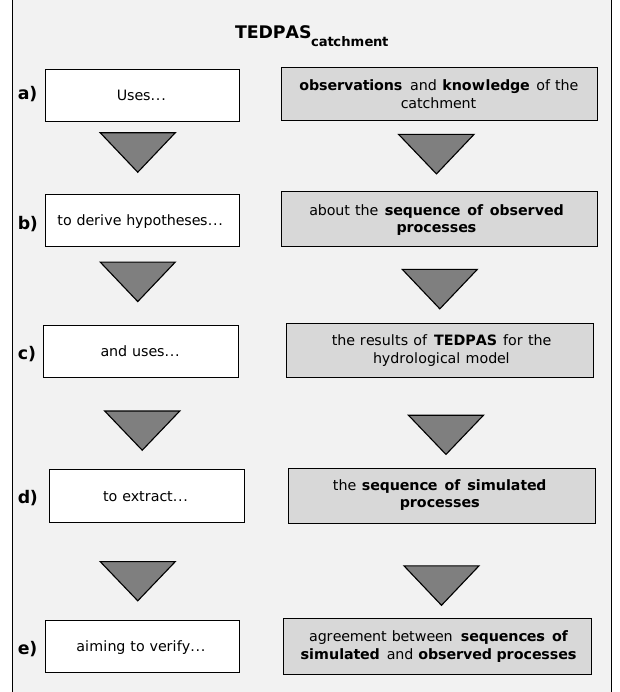
Figure 1. General idea of TEDPAS catchment as a verification frame- work. The framework integrates processes observed in the catch- ment (a) to derive hypotheses about the temporal sequence of ob- served processes (b) and the calculation of temporal parameter sen- sitivities with TEDPAS, (c) to extract the temporal sequence of sim- ulated processes (d) for the investigated hydrological model. The verification of the model is performed by comparing the temporal sequences of observed and simulated processes (e)